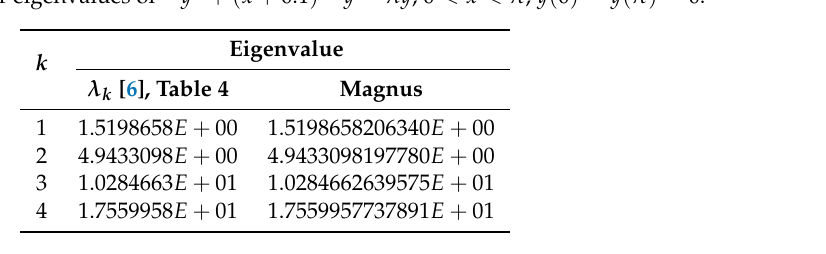
Table 2. Relative errors for the first four eigenvalues of − y (cid:48)(cid:48) + ( x + 0.1 ) − 2 y = λ y , 0 < x < π , y ( 0 ) = y ( π ) = 0. (Minimum relative error for each eigenvalue is in bold.) Relative Error k Magnus FDM [3] NM [4] FEM [5] MNM [6] FEMT [7] FEMS